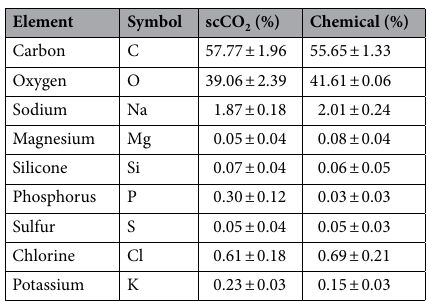
Table 2. Mass percentage (mean ± SD) of the elements present in the decellularized spinach scaffolds.